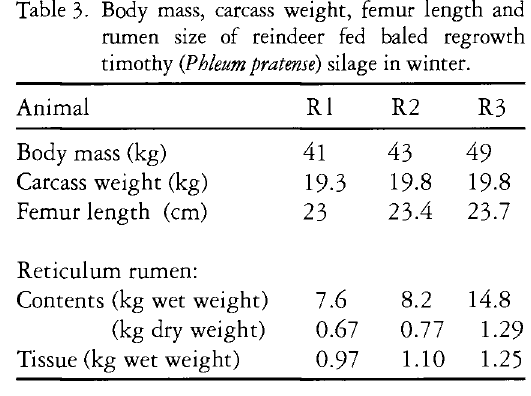
Table 3- Body mass, carcass weight, femur length